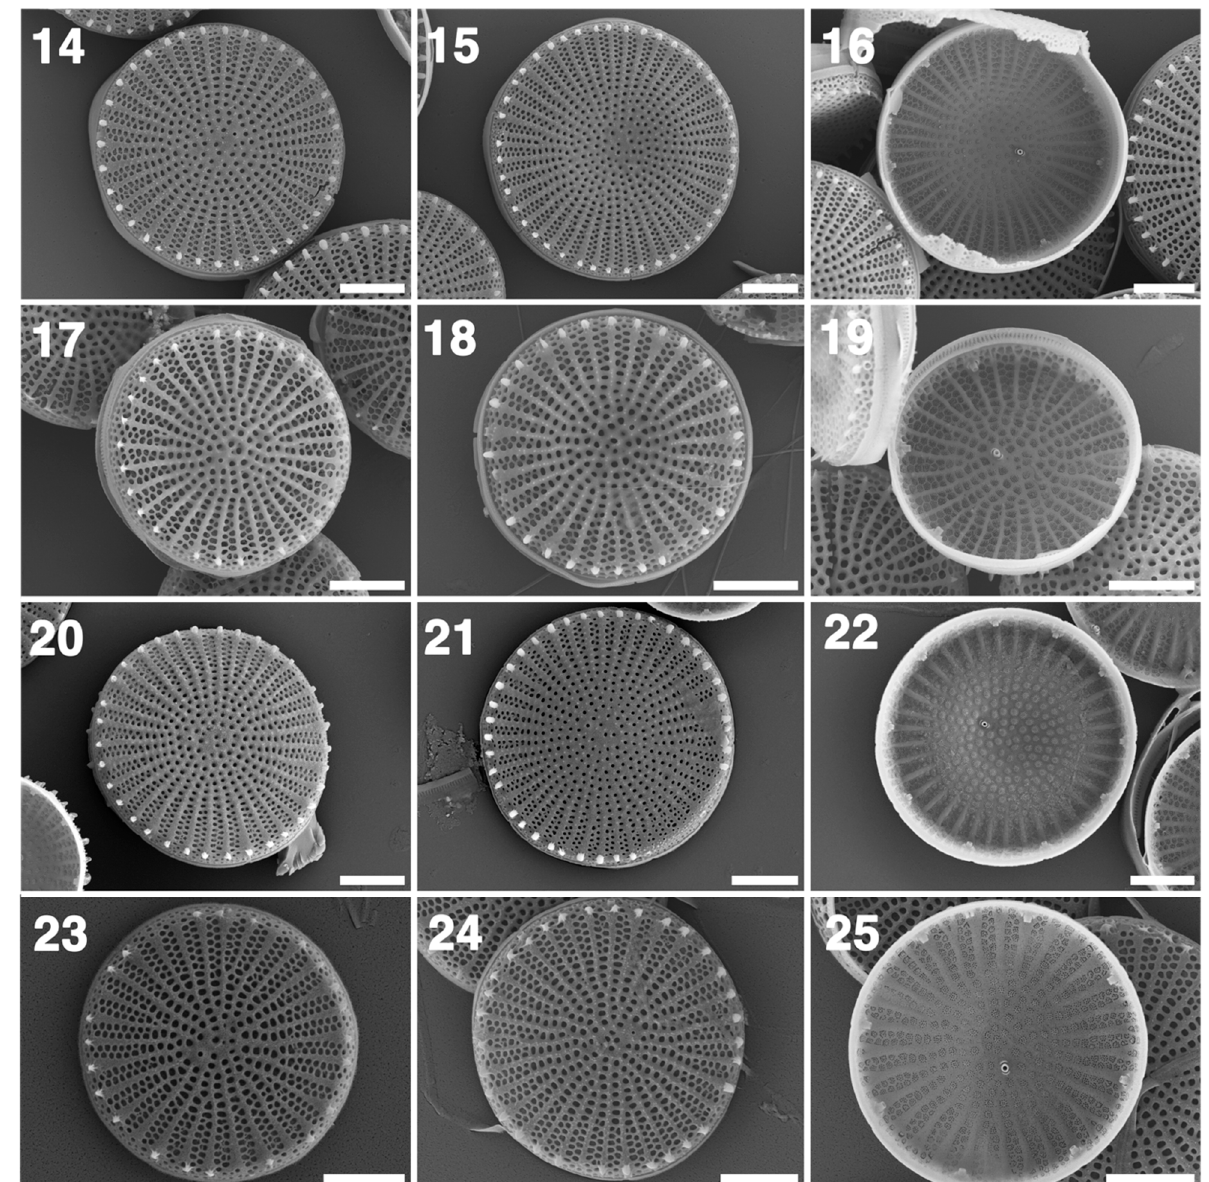
Figure 3. ( 14 – 25 ) SEM photographs of the internal and external ultrastructure of Cyclostephanos makarovae comb. nov. ( 14 – 16 ) strain STB1; ( 17 – 19 ) strain M13; ( 20 – 22 ) strain RIE1; ( 23 – 25 ) strain W36. Scale bars = 2 µm.